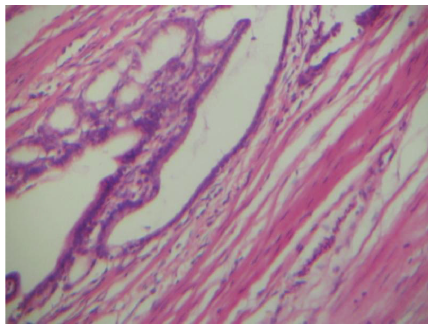
Figure 4: Gastric epithelium of the duplication (H&E × 40).